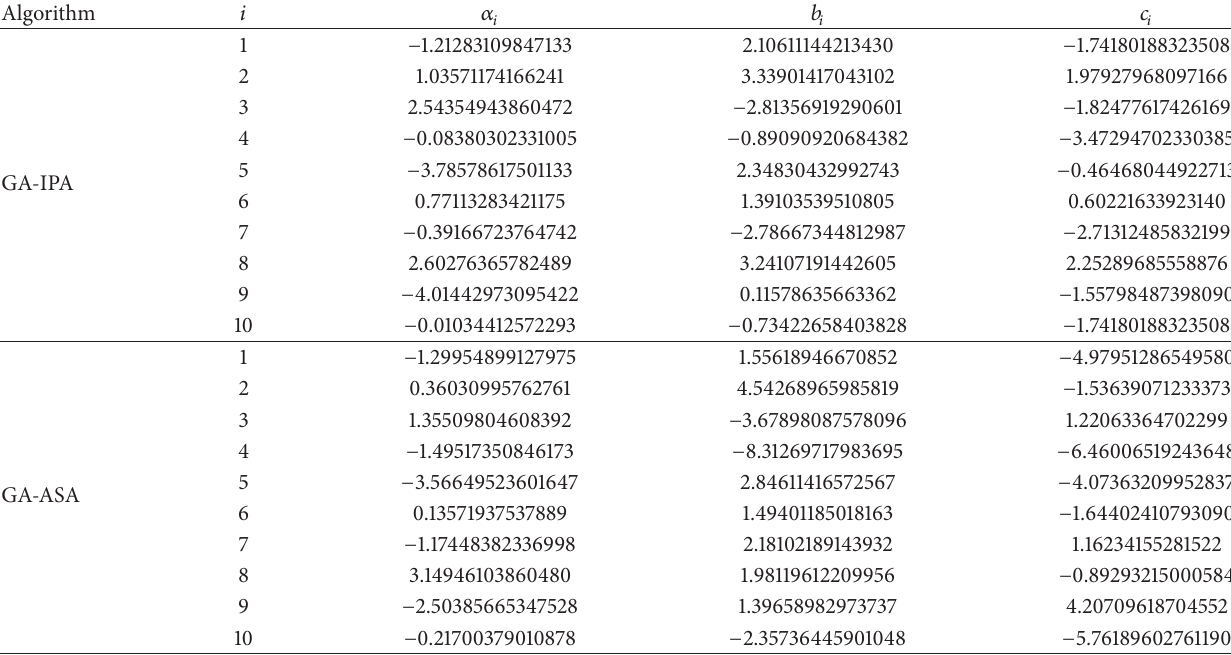
Table 9: Optimal values of adjustable parameters acquired by the hybrid schemes GA-IPA and GA-ASA (for 𝑚 = 0.25 ).